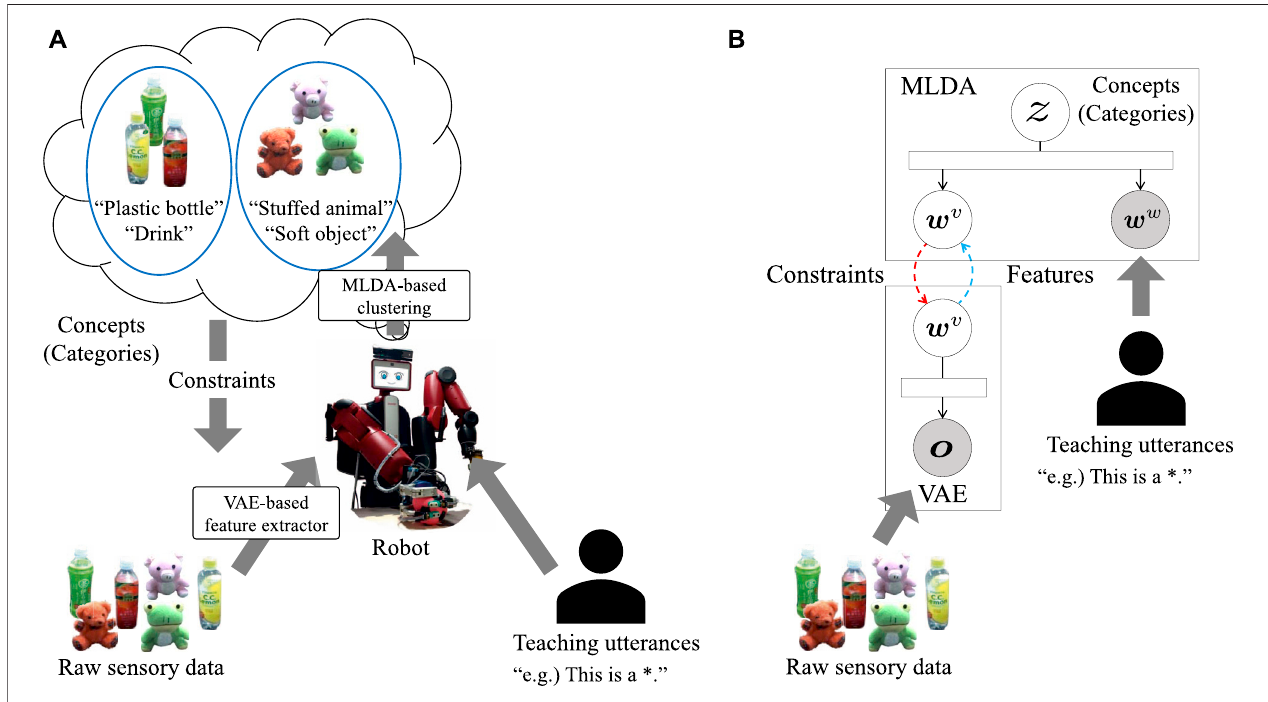
FIGURE 1 | Overview of study: (A) system and (B) corresponding integrated model